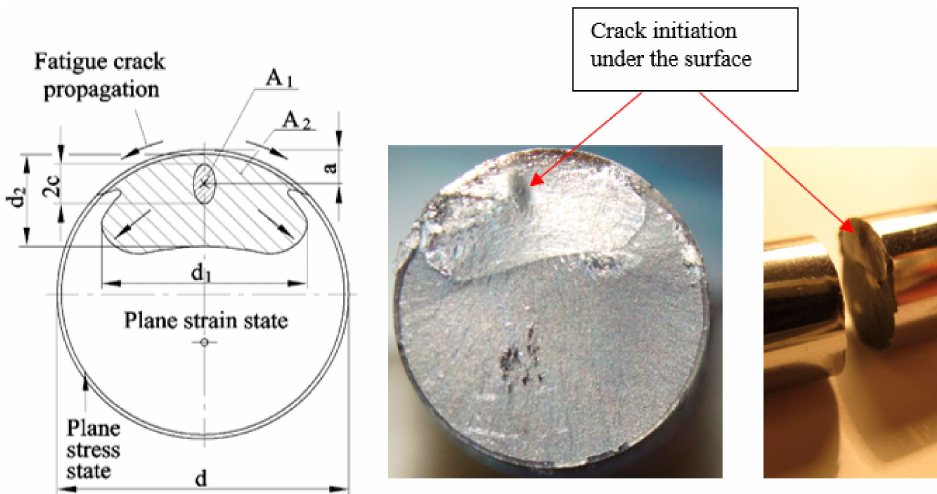
Figure 7. Fracture of the specimen oriented in the transversal direction of the specimen [4].